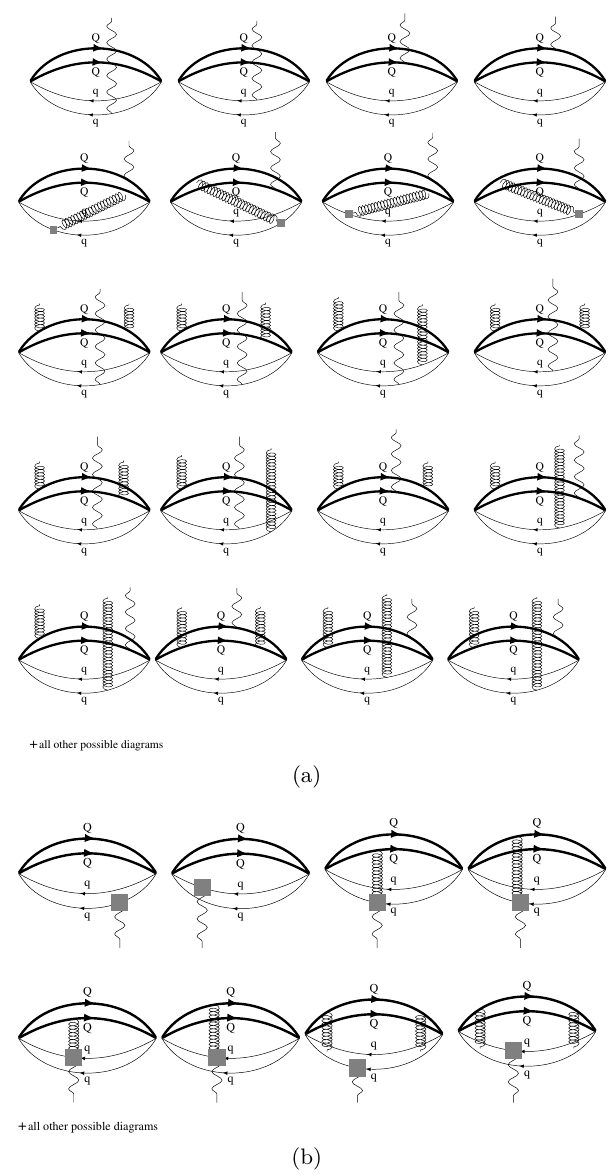
Figure 3 . Feynman diagrams for the magnetic dipole moments of the doubly-heavy tetraquark states. The heavy quark, light quark, photon and gluon lines are represented by the thick, thin, wavy and curly lines, respectively. Diagrams (a) correspond to the perturbative photon emission and diagrams (b) represent the contributions coming from the distribution amplitudes of the